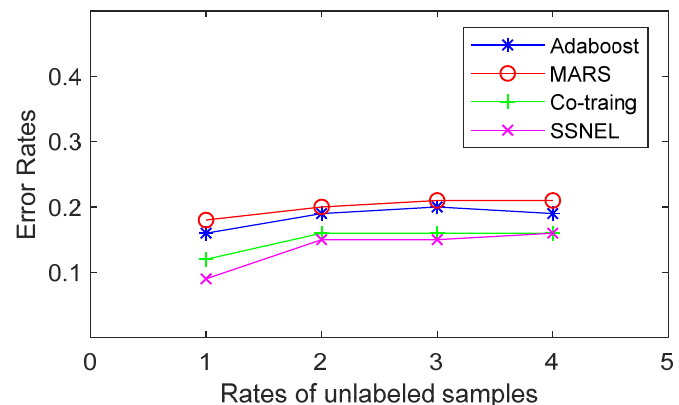
Figure 6. Error rates of the compared methods (yeast).